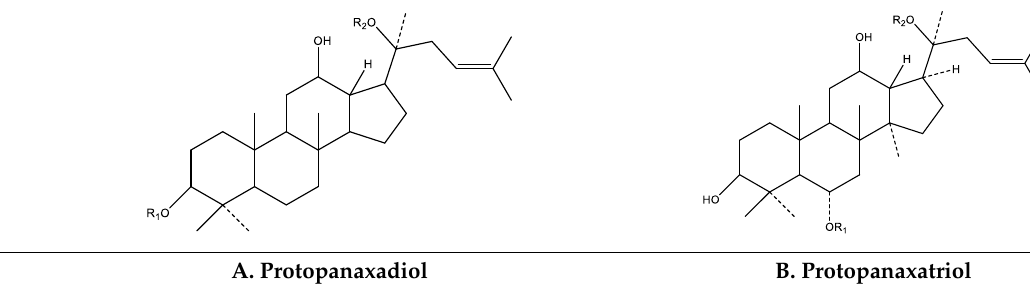
Figure 5. Panax ginseng C.A Meyer.